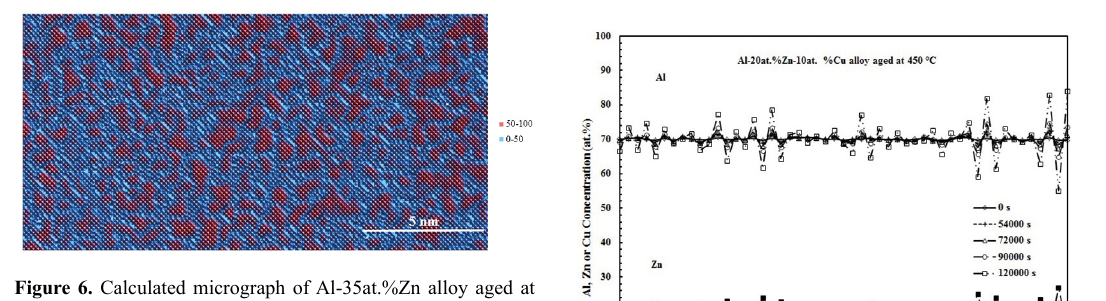
Figure 6. Calculated micrograph of Al-35at.%Zn alloy aged at 25 °C for 1500 s.